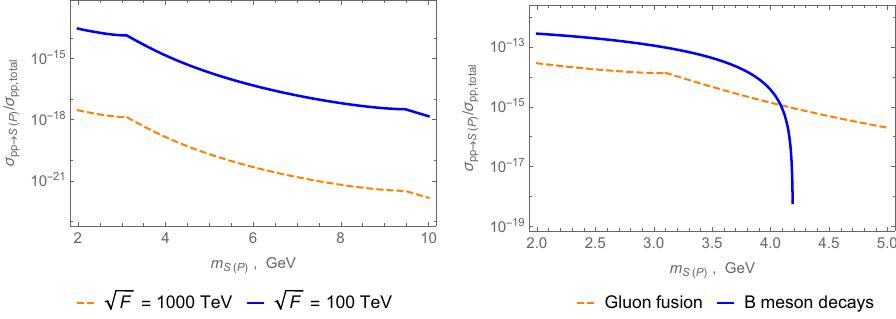
Figure 1. Cross sections of scalar and pseudoscalar sgoldstino production in gluon fusion as functions of sgold- stino mass. No di ff erence between scalar and pseudoscalar cases is expected (on the left panel). And cross sec- tions of scalar sgoldstino production in gluon fusion and in B -meson decays for the model with (on the right